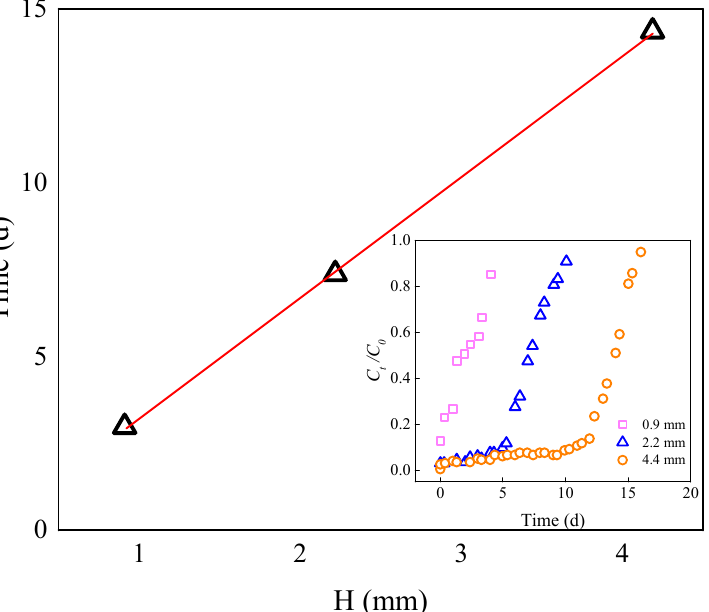
Figure 11. BDST model fitting diagram of carbon black adsorption device for removing TCS from water. Table 4. Error of fitting parameters and penetration time of BDST model.